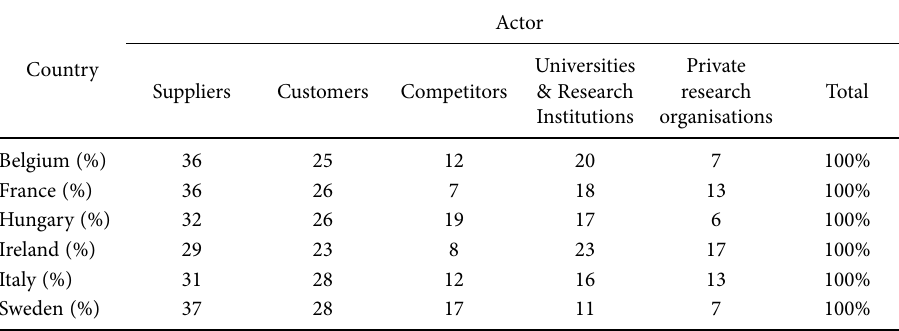
Table 3. Collaboration with different actors per country.